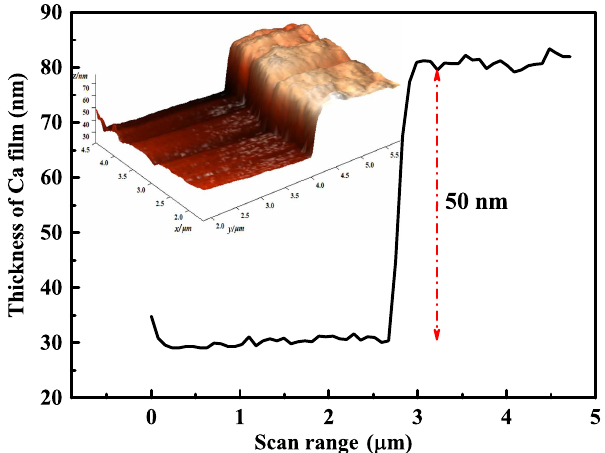
Figure 4. (Color online) The 50 nm thickness of the adsorbed atom film on the gap of electrodes tested by AFM, which comes from the AFM 3D image. There is a sharp increase at the 2.7 µ m position of the scan range, signifying the edge of the Ca atomic film.